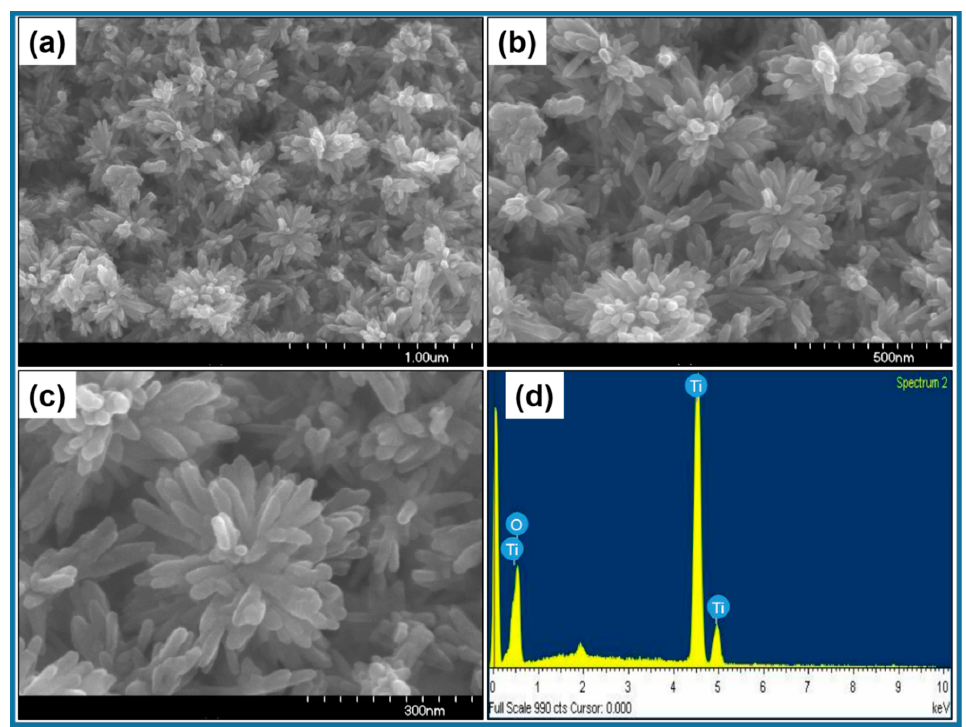
Figure 2. ( a – c ) FESEM images and ( d ) EDS spectrum of TiO 2 nanoflowers synthesized by facile low-temperature solution process. Materials 2019 , 12 , x FOR PEER REVIEW